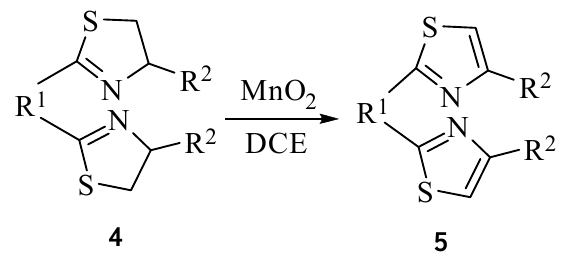
Scheme 2. The synthesis of 2,4-disubstituted bis-thiazoles.